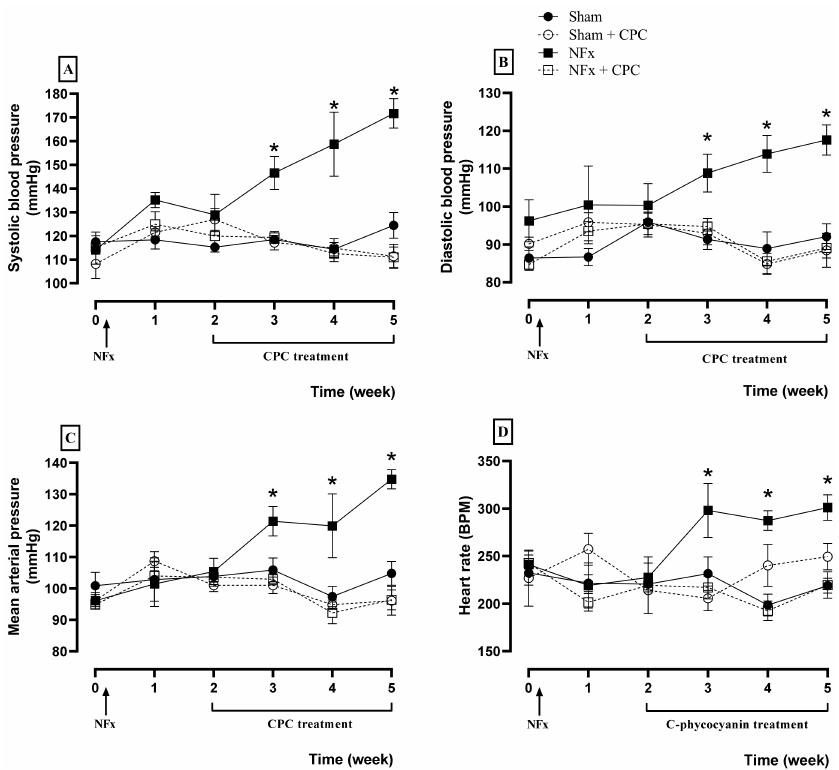
Figure 2. Effect of C-phycocyanin on systolic blood pressure ( A ), diastolic blood pressure ( B ), mean arterial pressure ( C ), and heart rate ( D ) of NFx rats. Values represent the mean ± SEM. (*) p < 0.05 compared to the sham group at the same time. RM two-way ANOVA and SNK post hoc